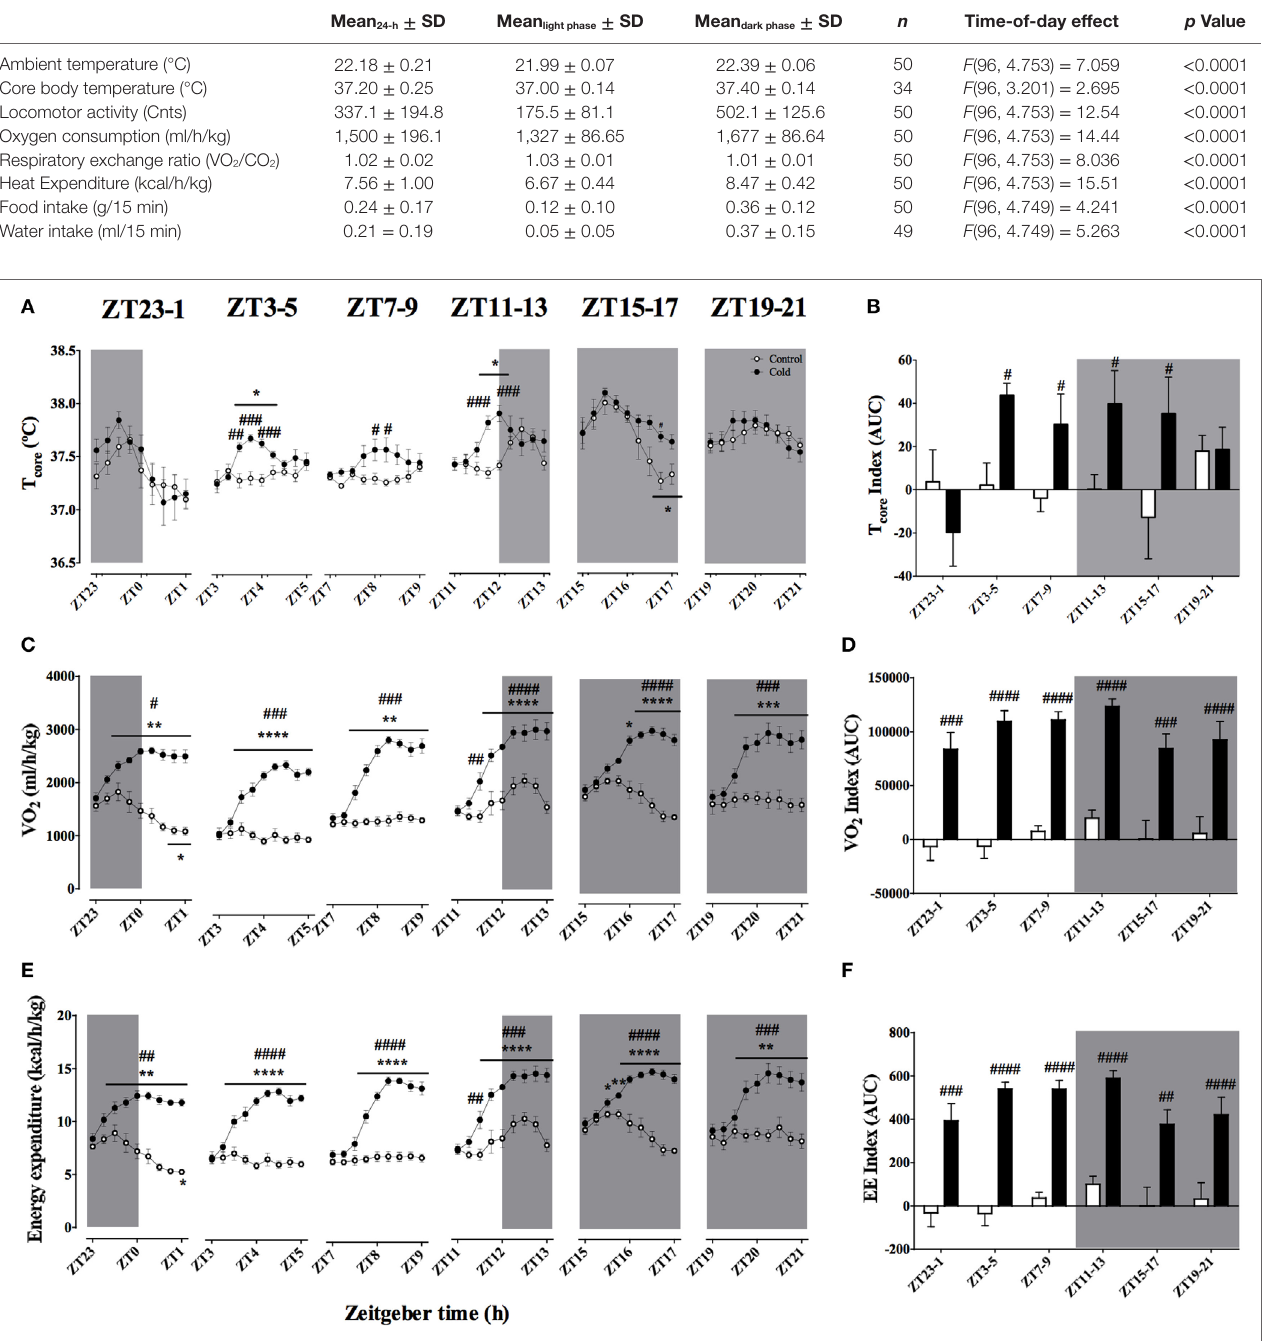
TaBle 2 | Mean basal 24­h and light/dark levels of thermal, behavioral, and metabolic parameters under control conditions (24 h before environmental